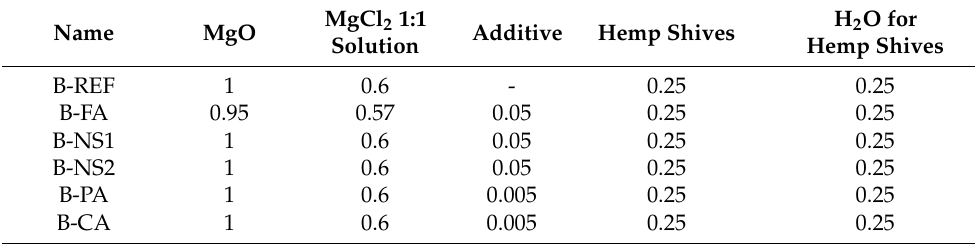
Table 4. Bio-composite mix proportions.